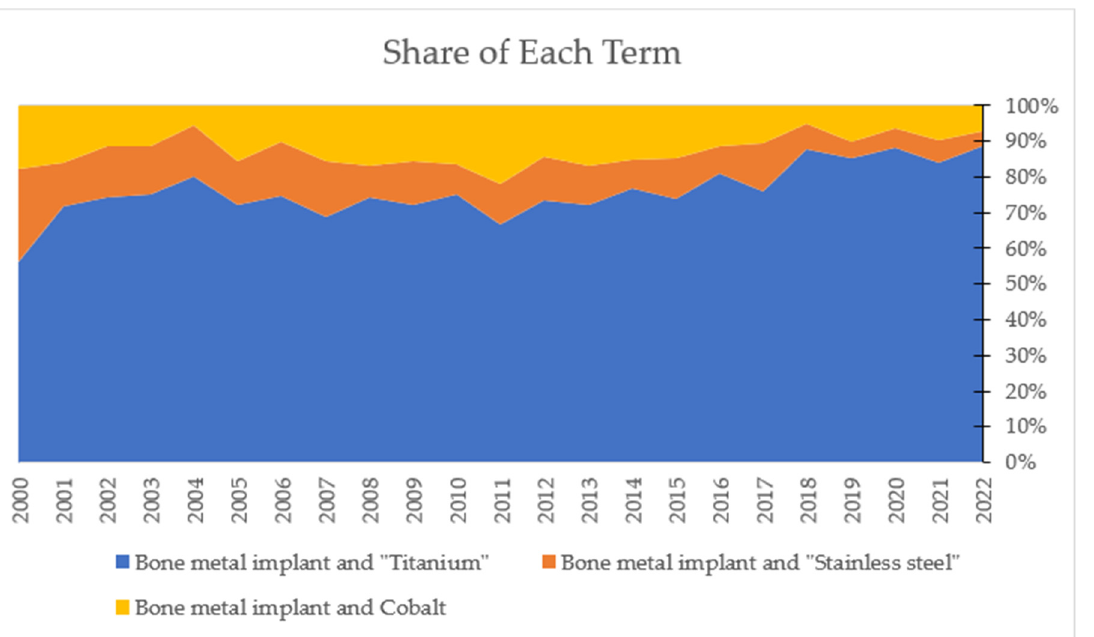
Figure 16. Number of publications for each search term in the Scopus online database.